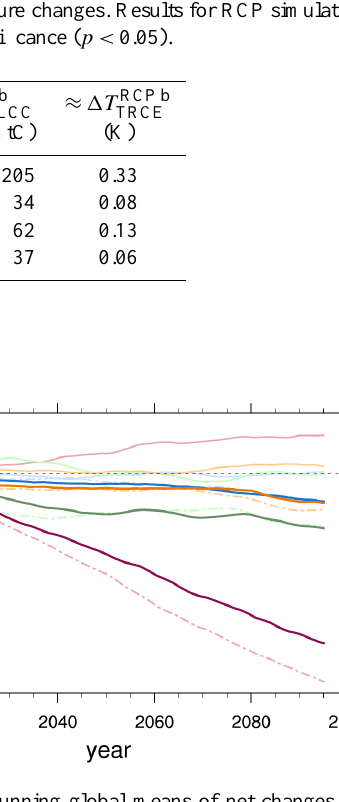
Figure 3. The 10-year running global means of net changes due to LULCC in the terrestrial carbon content (in GtC). Dark solid lines represent 1C net , dashed lines 1C 1 LULCC and light solid lines 1C BGC